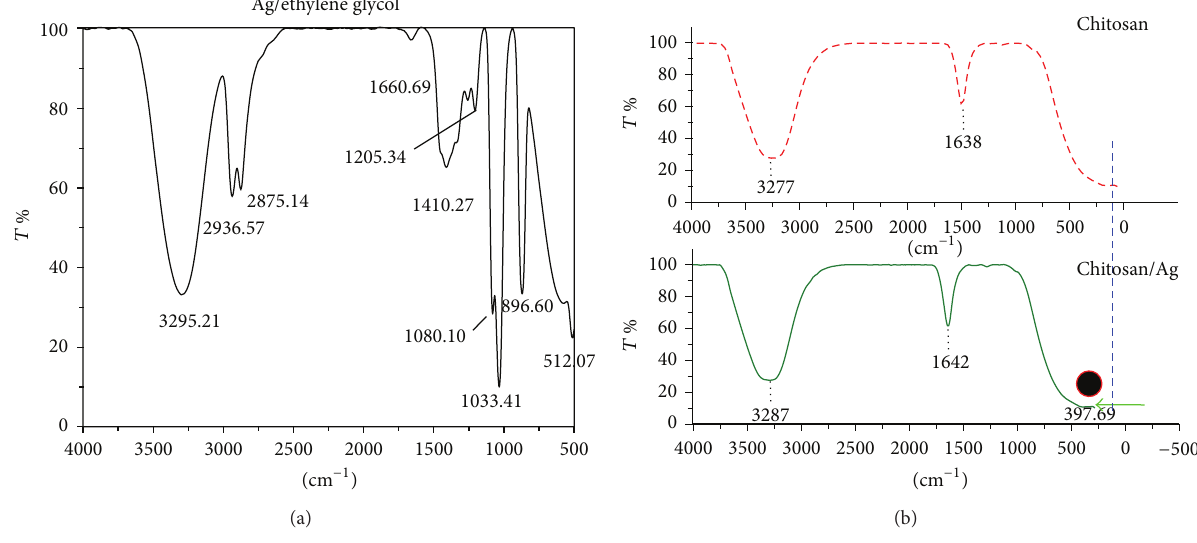
Figure 5: FT-IR spectra of Ag-NPs in (a) EG and (b) chitosan using LA.